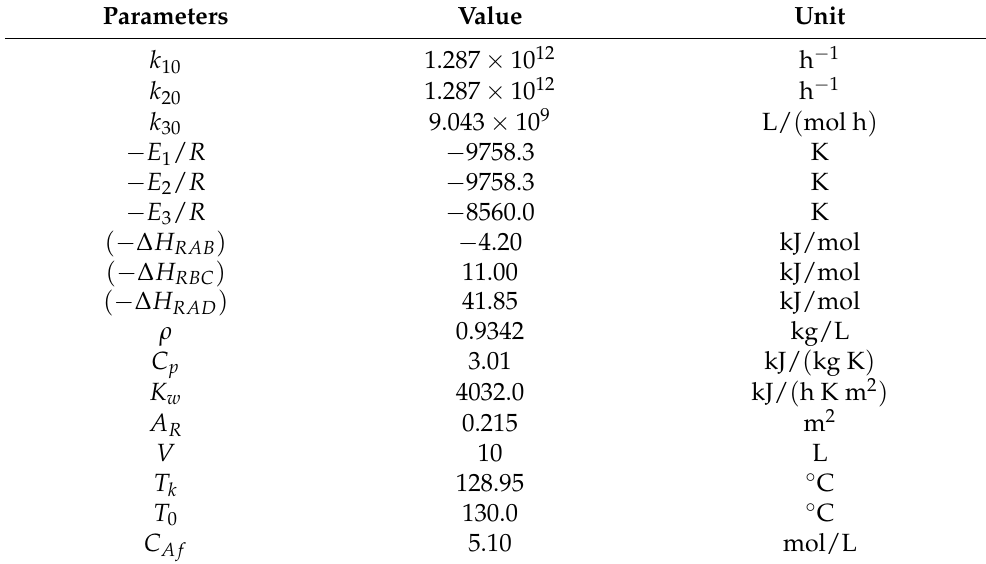
Table 3. Van de Vusse parameters.